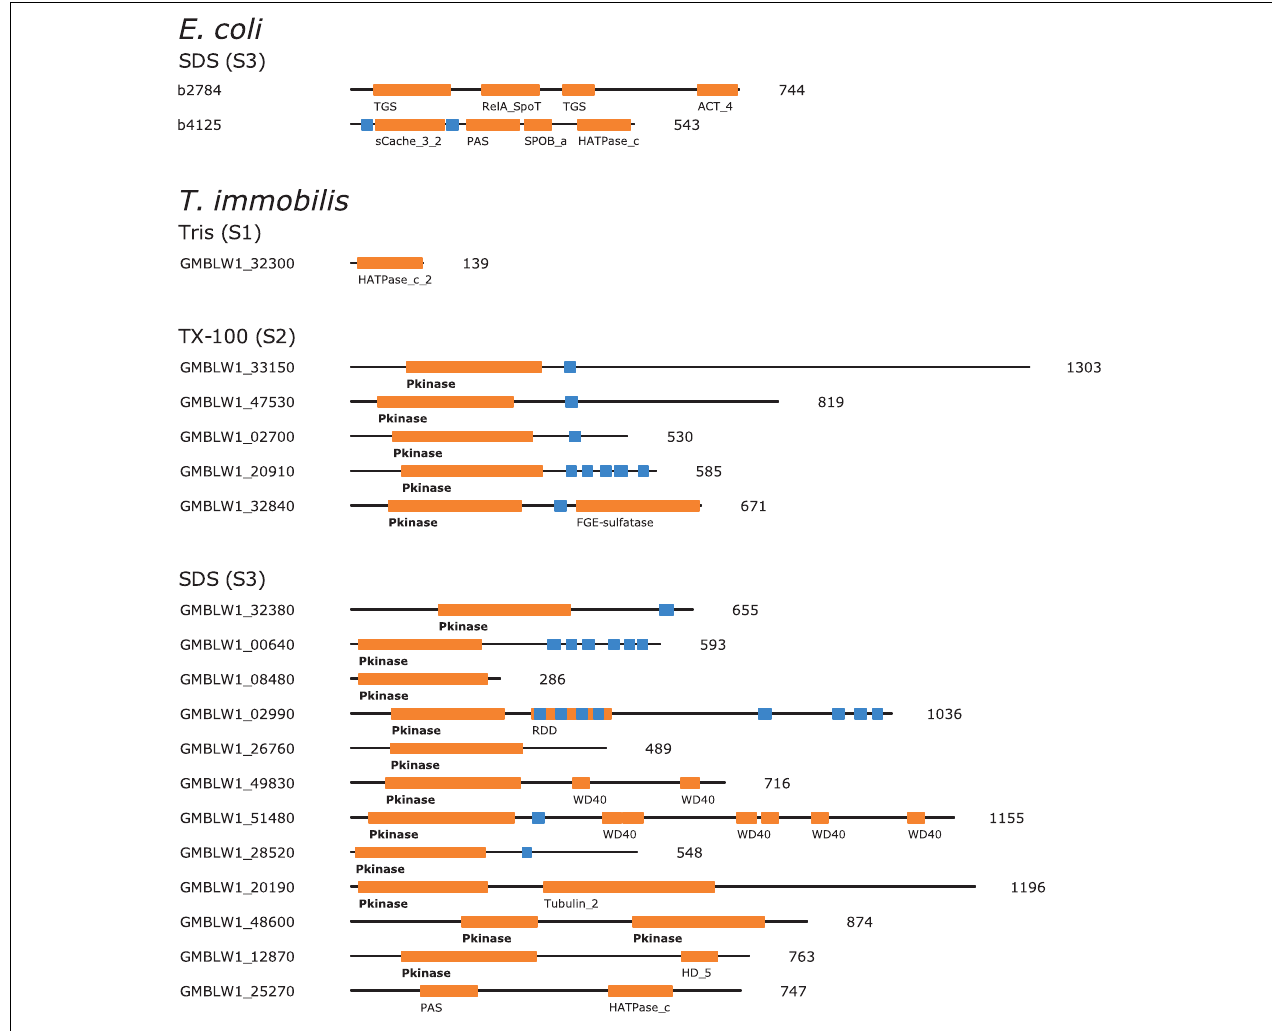
FIGURE 12 | Domain architecture of fraction-specific proteins with kinase domains identified in the subcellular proteomes of T. immobilis and E. coli . The Pfam domains are highlighted with orange boxes and the respective domain ID. Blue boxes indicate the location of predicted transmembrane domains based on Phobius 1.01. The protein lengths are indicated besides each domain